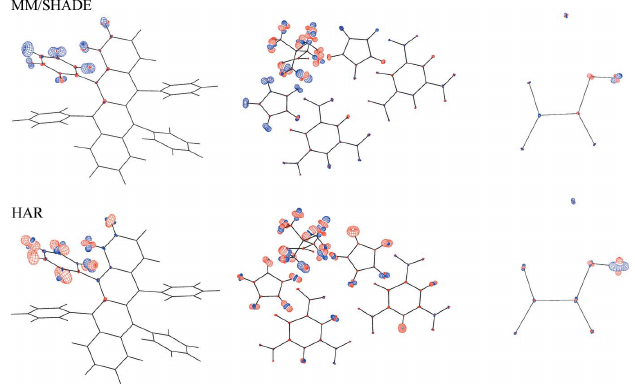
Figure 6 Difference between neutron ADPs and those from MM/SHADE (top) or HAR refinements (bottom) for rubrene (left), BIPa (middle) and KHOx (right). The basis set was rhf/def2-TZVP, with charges or with a cluster, Figure 5 and the plots were drawn using the PEANUT software (Hummel et al. , = csu for the hydrogen ADPs 1990). The plots refer to a 50% probability level of the ADP RMSDs, Histograms showing binned ratios of (cid:2) U ij X - N scaled by a factor of 2. Blue denotes positive and red negative. of rubrene and BIPa.